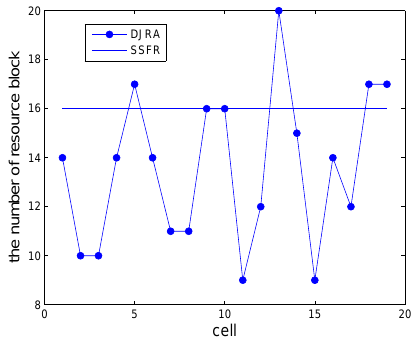
Figure 4. Cell-edge resource blocks (RBs) distribution of dynamic joint resource allocation algorithm (DJRA) and static soft frequency reuse